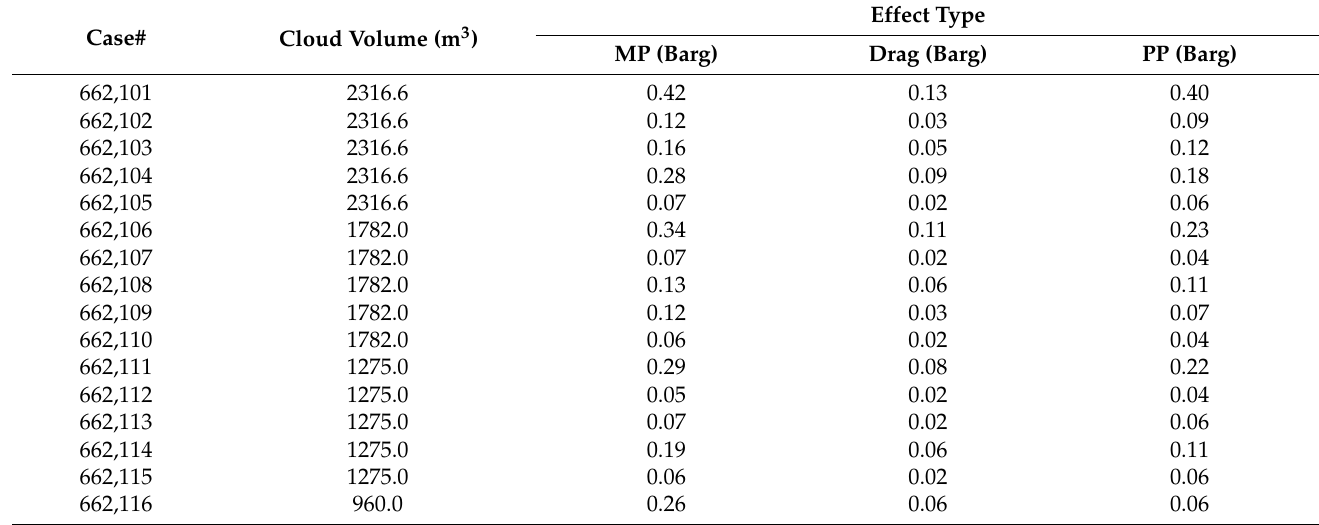
Table 4. Main explosion simulation results read in all targets for Leak